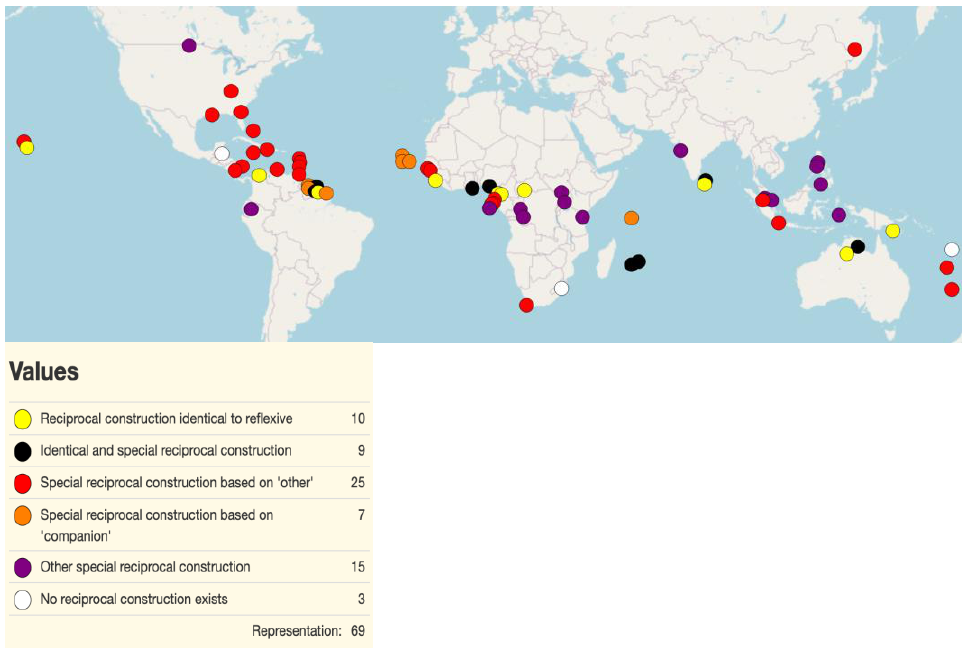
Figure 1. Reciprocal constructions in creole, pidgin, and mixed languages, feature 89, APiCS